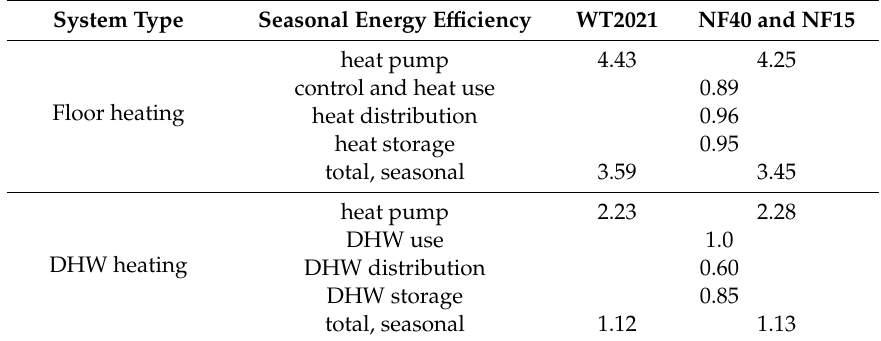
Table 10. Calculation of total energy e ffi ciency of floor and DHW heating systems with